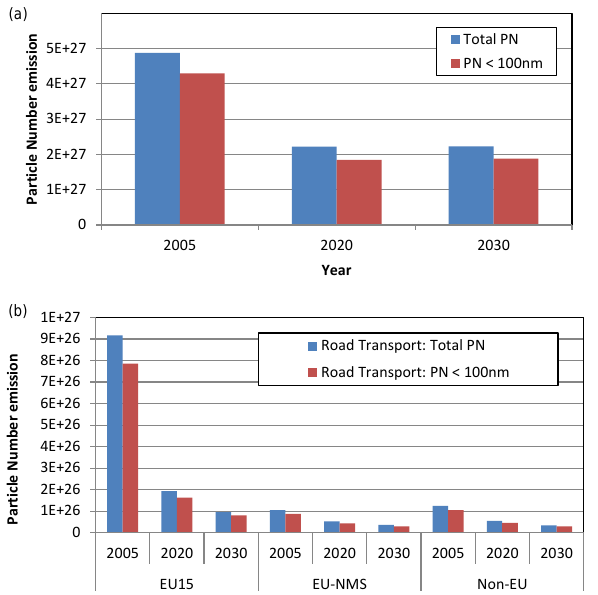
Figure 3. (a) Total anthropogenic particle number emissions and total particle number emissions in the particle size range of 10– 100nm for UNECE Europe for 2005, 2020, and 2030 and (b) the same emissions exclusively for road transport, segmented by coun- try group. NMS refers to the new member states, i.e., EU12 + .